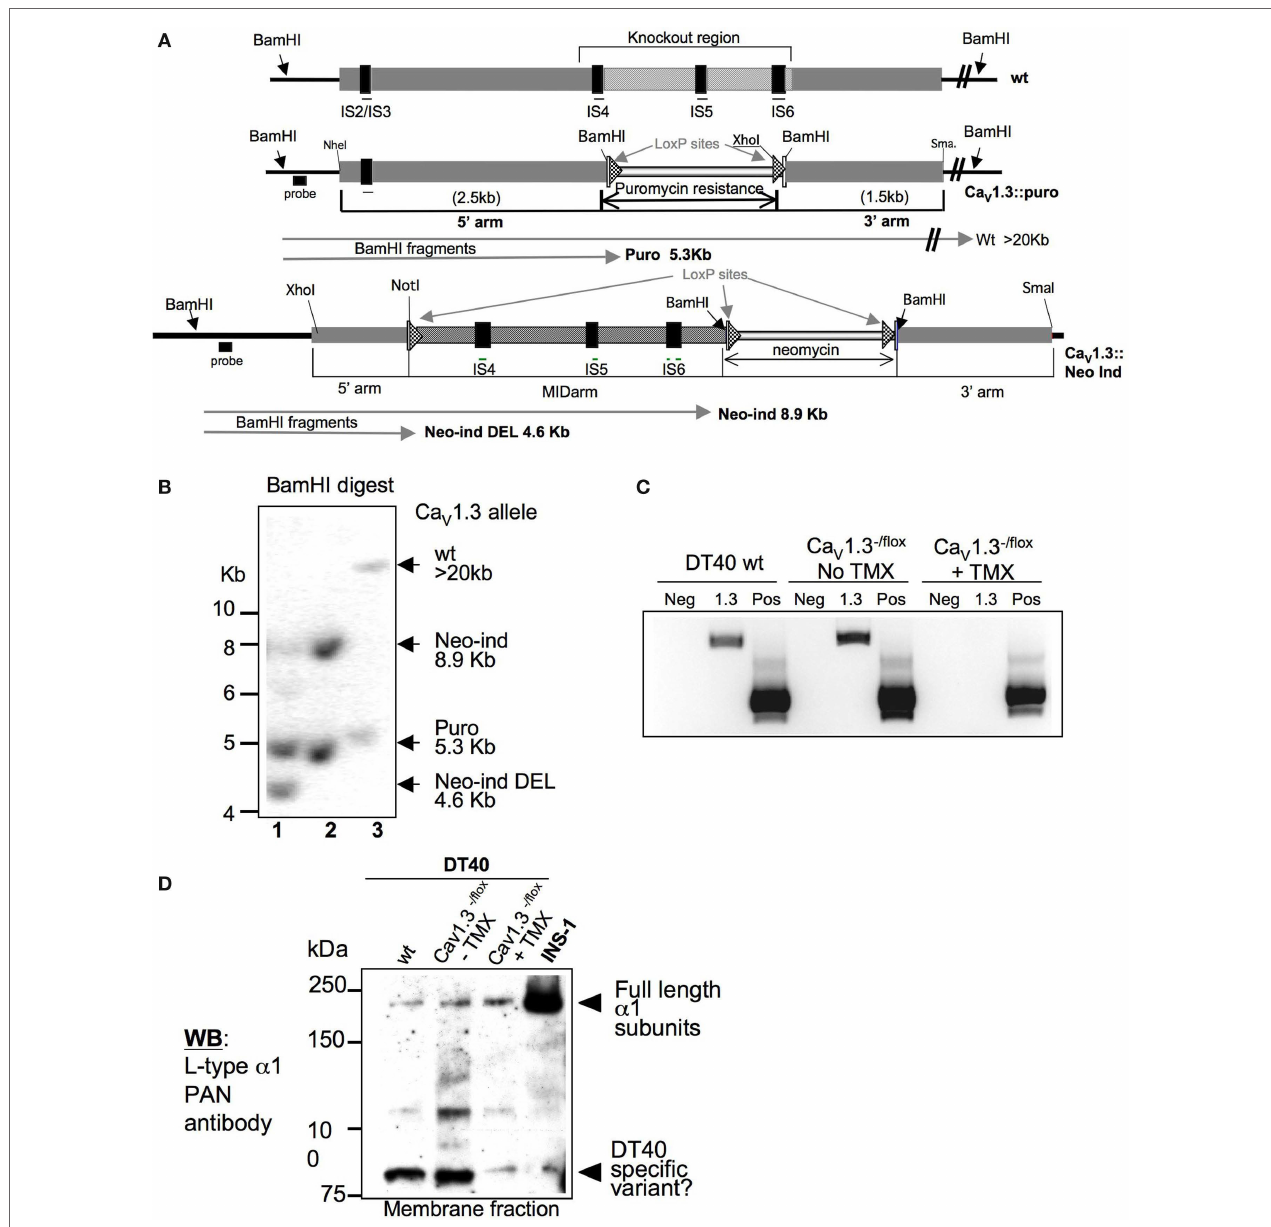
(lane 2)-induced deletion of the cacna1d region of interest in comparison to a cacna1d ± clone (lane 3). (C) RT-PCR of wild-type DT40 cells and of one Ca V 1.3 flox/ − clone before and after tamoxifen (TMX)-induced deletion of the cacna1d region of interest using cacna1d -specific primers. The unrelated chicken nudT9 gene was used as a positive control (Pos) to verify the quality of the cDNA. Neg control is RNA only. (d) Western blot of membrane fraction lysates of wild-type DT40s and excitable INS-1 rat pancreatic cells in comparison to one Ca V 1.3 flox/ − clone before and after tamoxifen-induced cacna1d